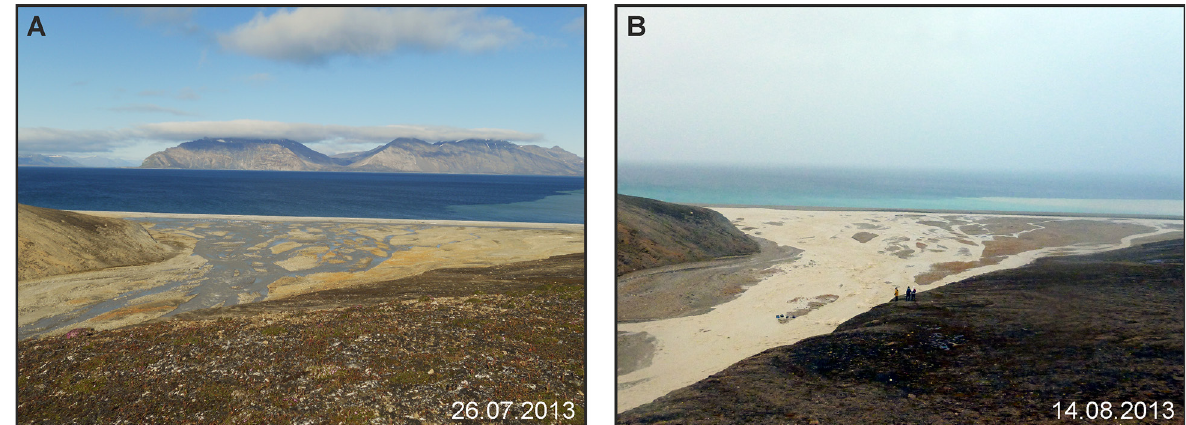
Fig. 6. Flooding in the mouth section of the Scott River in the research season 2013: A – before the flooding, B – during the